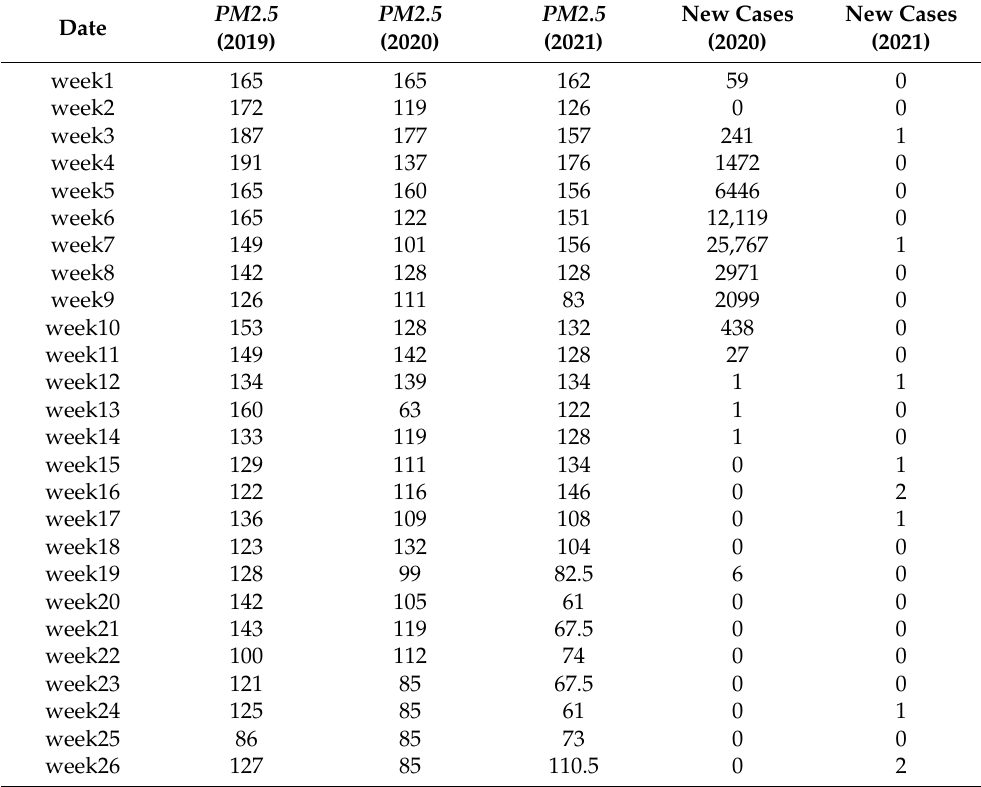
Table 1. Median PM2.5 value for each week and weekly new COVID cases in